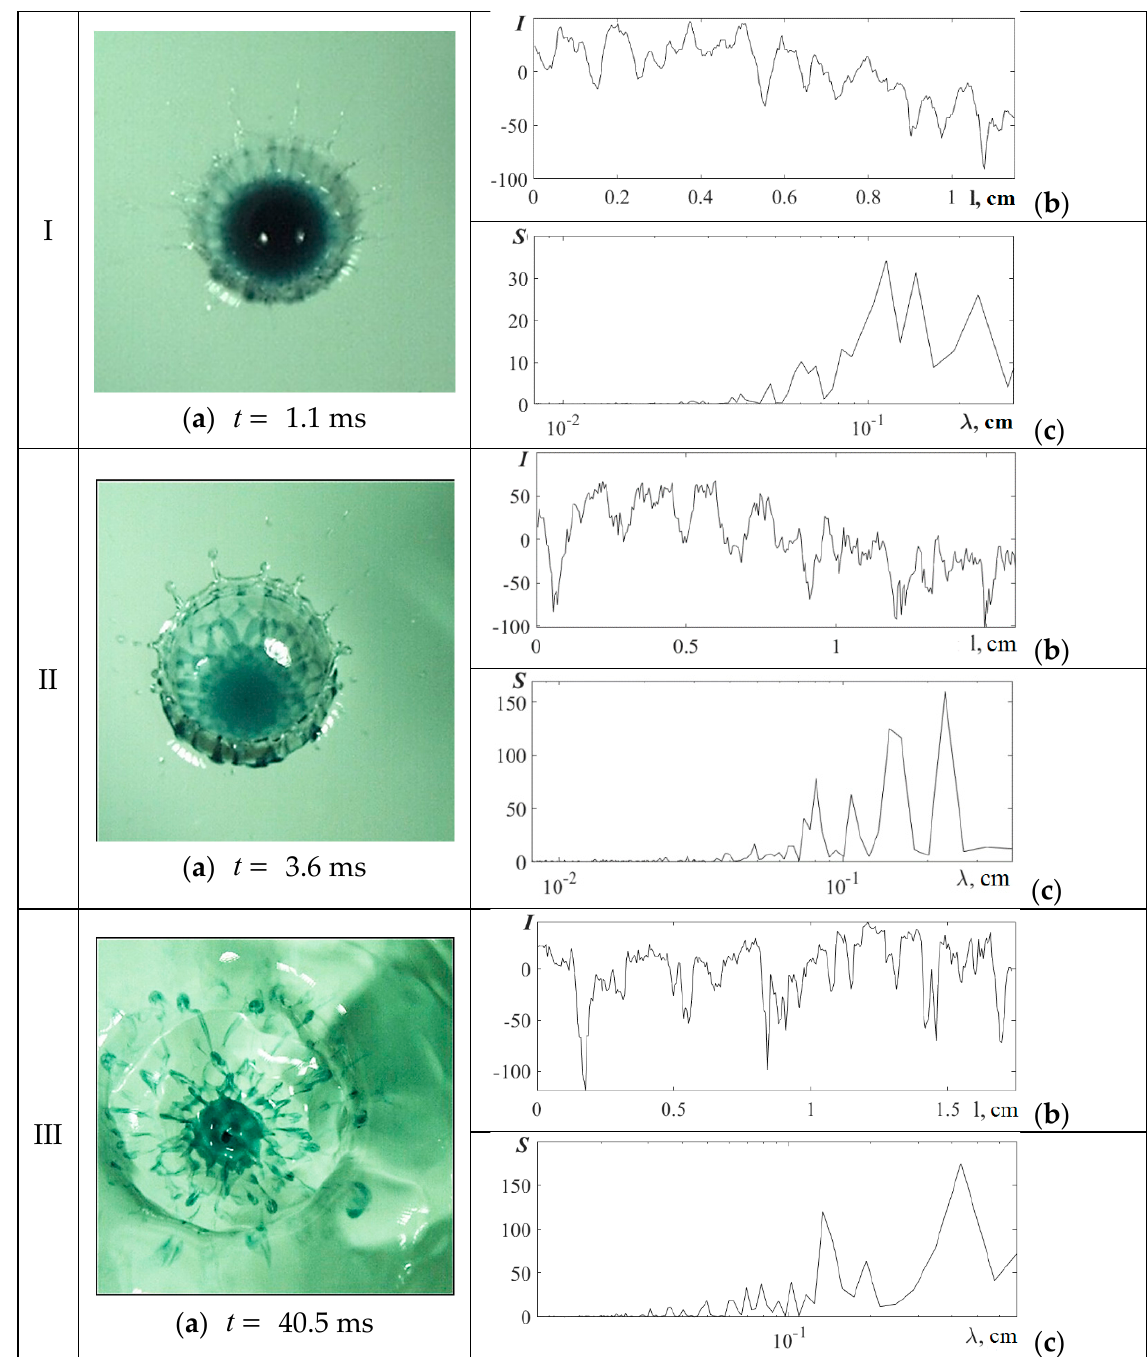
Figure 12. Azimuthally distributions of the colored area illumination of the drop impact patterns in selected frames I, II and III: ( a )—selected frames at t = 1.1, 3.6, 40.5 ms in Figure 11. ( b )—illumination I , ( c )—spatial spectra S .